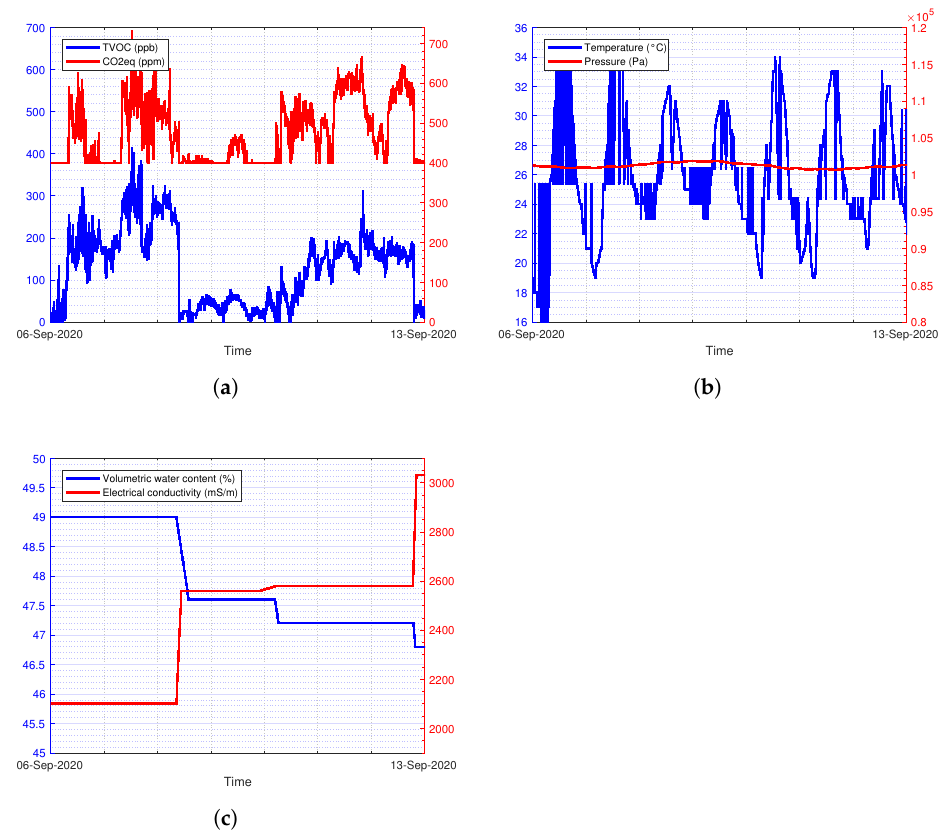
Figure 9. Experimental data waveforms collected from the test field, during the olive farming activity, in a time interval of 1 week: ( a ) TVOC and eCO 2 measured in ppb and ppm, respectively; ( b ) temperature and pressure measured in °C and Pa, respectively; ( c ) volumetric water content (VWC) and electrical conductivity measured in % and mS/m,